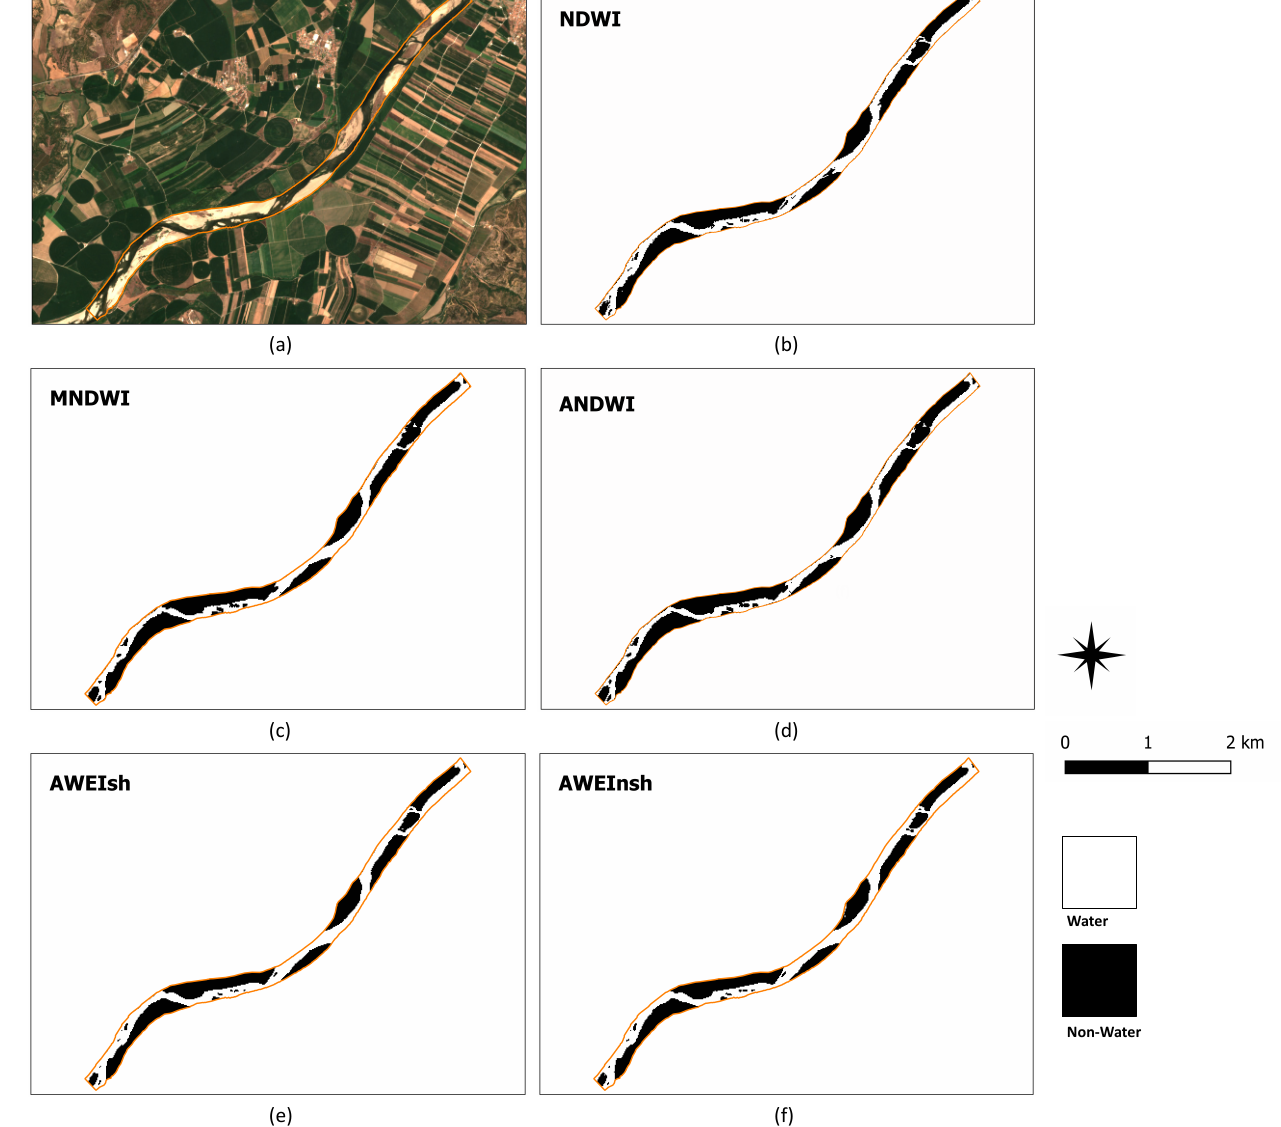
Figure 9. ( a ) View of the selected segment of the Lower Tagus River (Portugal) and adjacent areas. ( b – f ) Water and sandbar (non-water) mapping of the river segment based on the classification of water indices calculated using Sentinel 2 data (8 July 2022). The class separation threshold was estimated by manual decision. Data resolution is 20